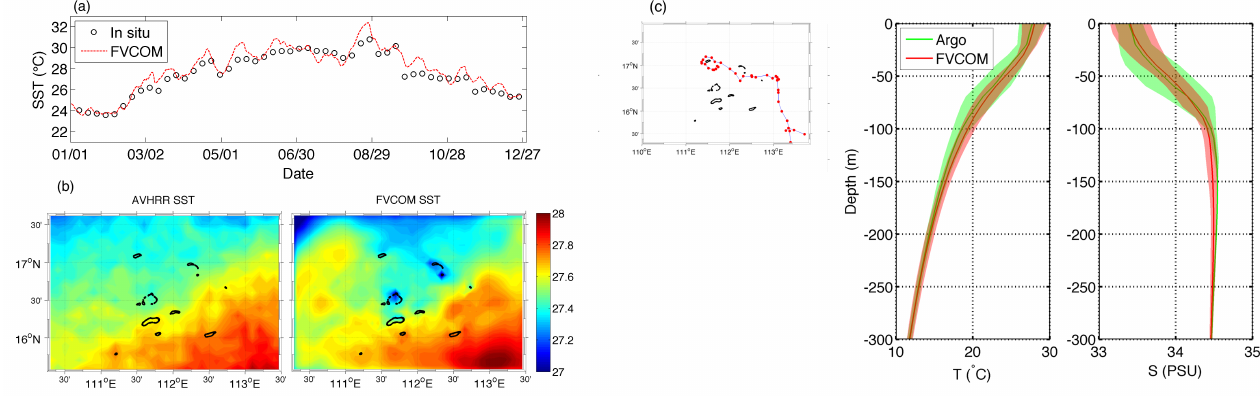
Figure 3. Comparison of the modeled time sequences for: ( a ) the SST and ( b ) annual averaged SST against AVHRR during 2009 and ( c ) modeled means and standard deviations (shade) of vertical temperature and salinity against Argo data. The Argos were present in the XA from 9 August to 27 December 2009, and the trajectories are depicted in the figure on the left. Color codes are in ◦ C.